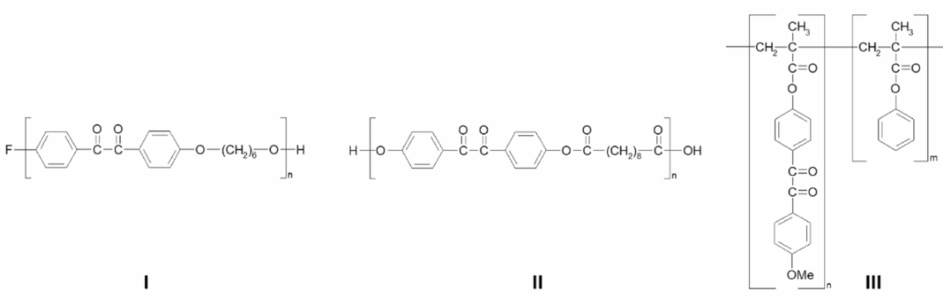
Figure 2. Structures of copolymers: poly(oxyhexyleneoxy-4,4 (cid:48) -benzilylene) (I), poly(oxy-4,4 (cid:48) -benzilyleneoxysebacoyl) (II) and poly(phenyl methacrylate-co-4-methacryloyloxy-4 (cid:48) -methoxybenzil) (III).